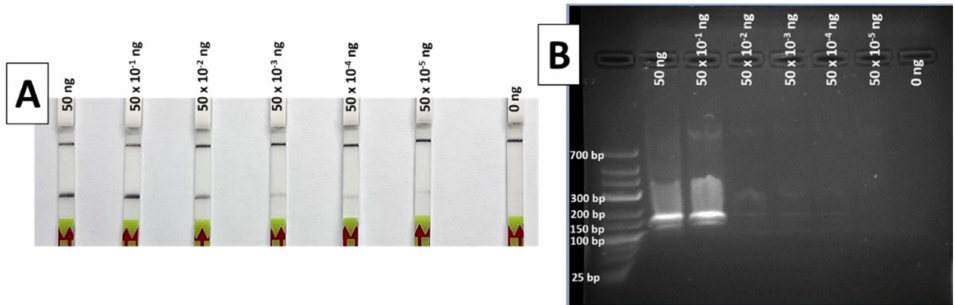
Figure 4. Results of the limit of detection test of the RPA method, with LFA ( A ) and 2% agarose gel ( B ). Total ng of DNA per reaction was 50, 50 × 10 − 1 , 50 × 10 − 2 , 50 × 10 − 3 , 50 × 10 − 4 , 50 × 10 − 5 and 0 ng, from left to right in both